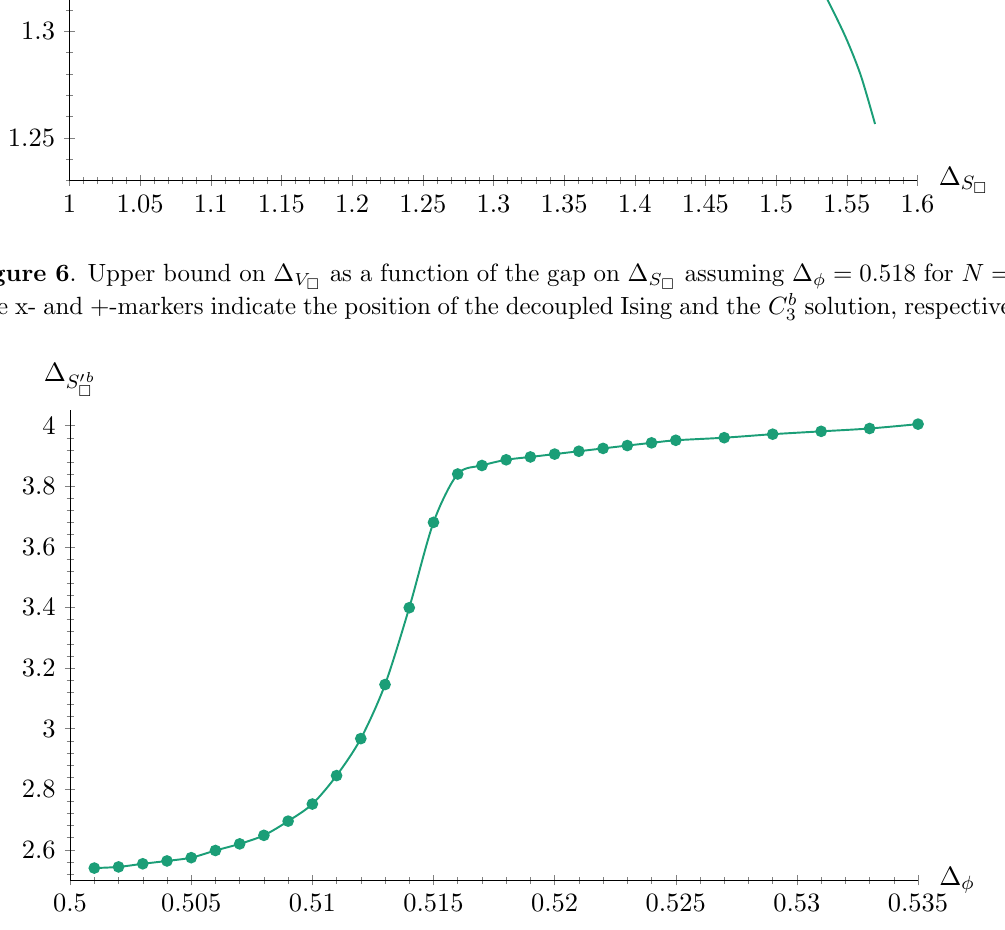
is equal to the bound (cid:3)